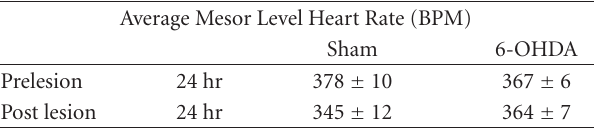
Table 1: Average mesor level heart rate values ( ± SEM) for the two groups. BPM =